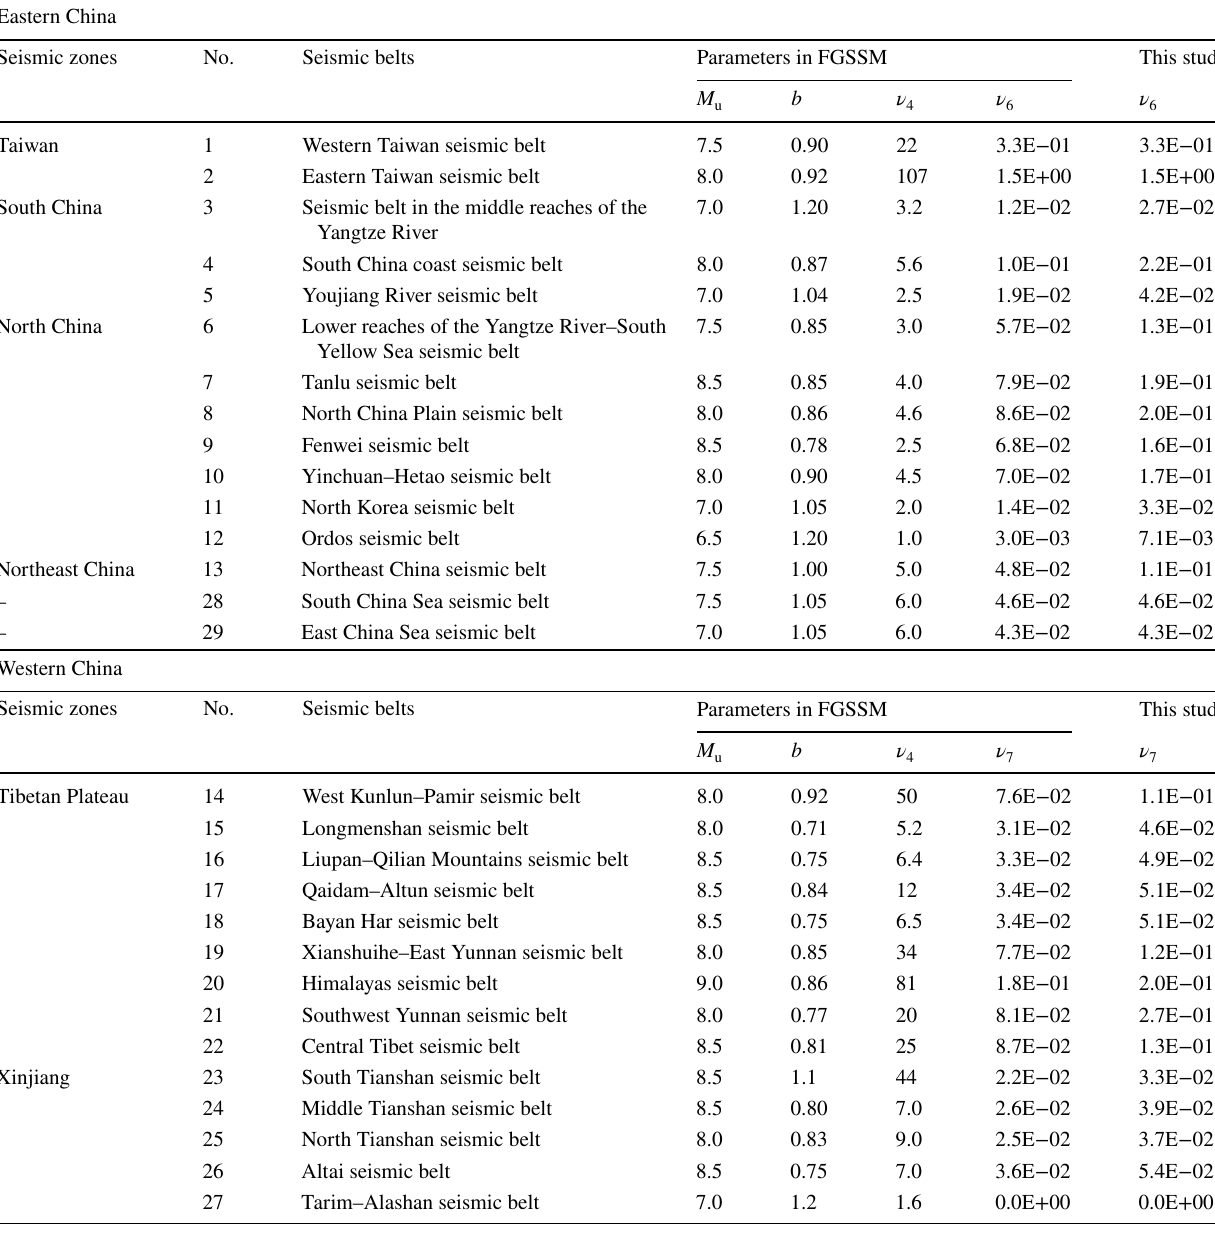
Table 1 Seismicity parameters for the seismic belts of